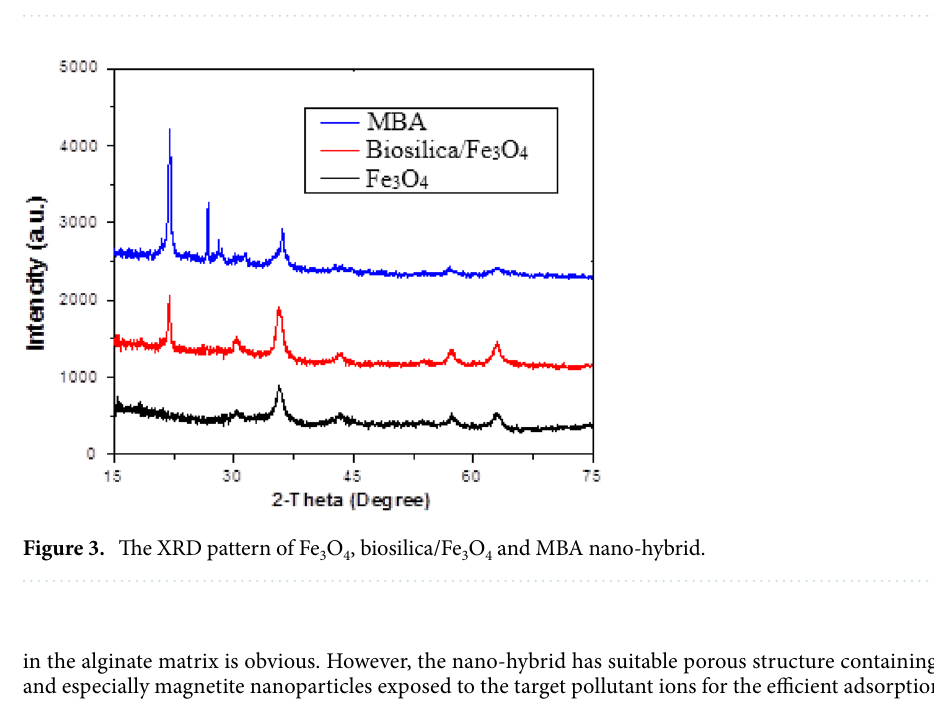
Figure 2. FT-IR spectra of Fe 3 O 4 , biosilica/Fe 3 O 4 and MBA nano-hybrid.